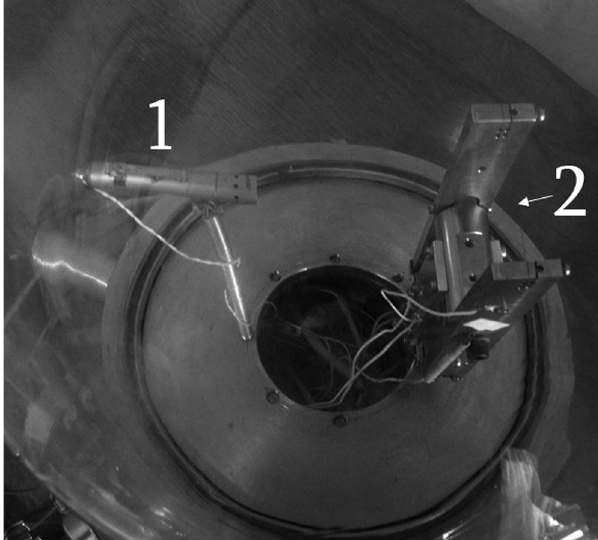
FIG. 6. Experimental setup for response time measurement. 1: diode laser; 2: VWM target wire.